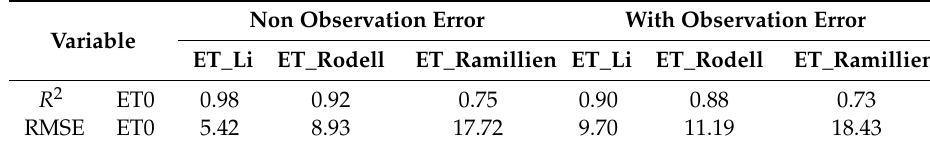
Table 2. The correlation coefficient ( R 2 ) and RMSE between ET0 and ET